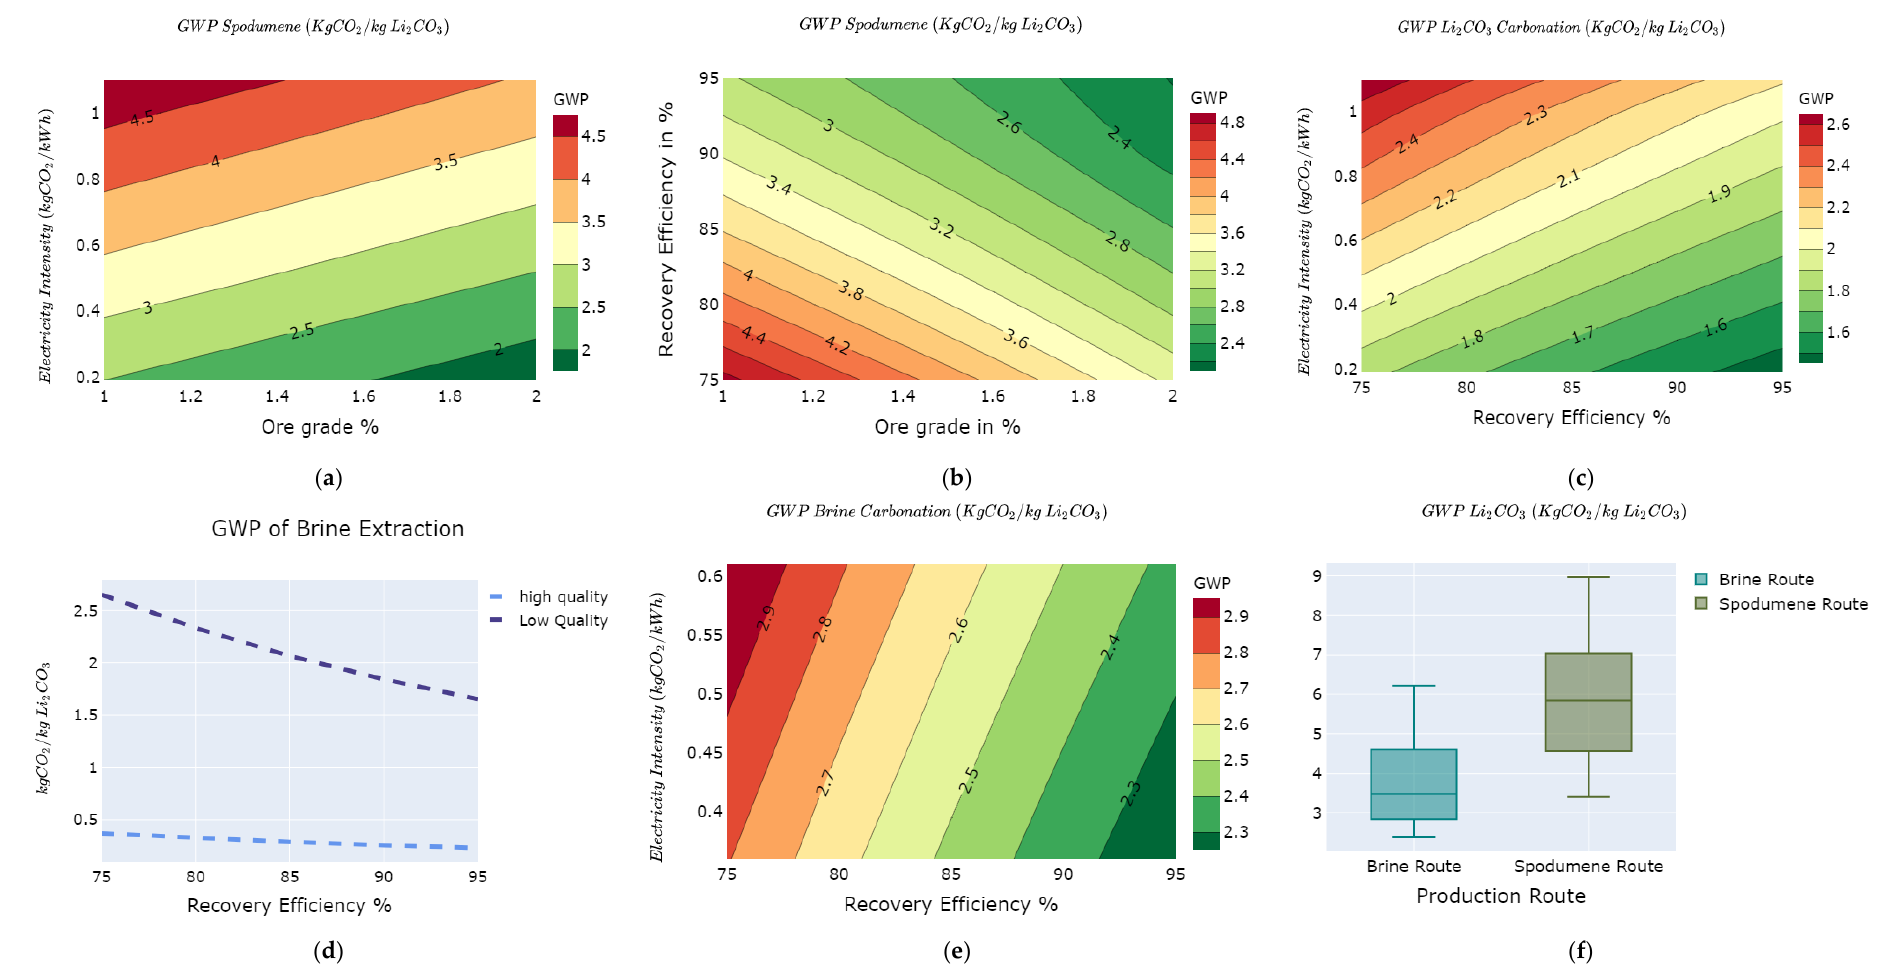
Figure 5. GWP variability on the LCE value chain as functions of: ( a ) ore grade vs. electricity mix intensity for spodumene; ( b ) ore grade vs. recovery efficiency for spodumene; ( c ) recovery efficiency vs. electricity mix for carbonation via spodumene route; ( d ) brine grade vs. electricity mix intensity; ( e ) recovery efficiency vs. electricity mix for carbonation via brine route; and ( f ) overall GWP variations LCE value chain.